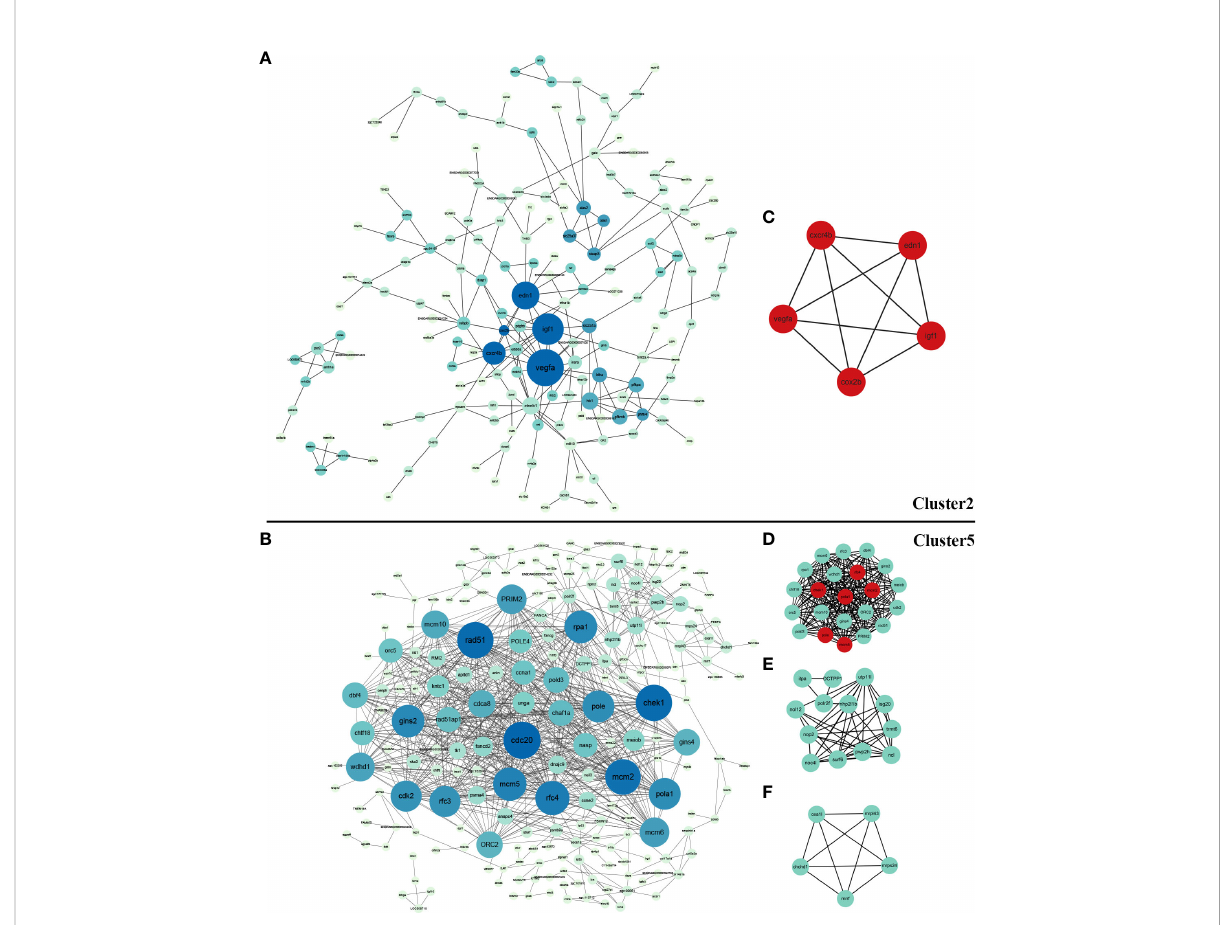
FIGURE 4 Protein-protein interaction (PPI) network and signi fi cant module of DEGs in cluster 2 and cluter 5. (A) PPI network of DEGs in cluster 2 created by STRING and visualized using Cytoscape software; (B) PPI network of DEGs in cluster 5 created by STRING and visualized using Cytoscape software; (C) The signi fi cant module of cluster 2 identi fi ed by MCODE (score = 5.000). The hub genes identi fi ed by Cyto-Hubba analysis were shown in red; (D) The most signi fi cant module of cluster 5 identi fi ed by MCODE (score =20.286); (E) The second signi fi cant module of Cluster 5 identi fi ed by MCODE (score =7.167); (F) The third signi fi cant module of Cluster 5 identi fi ed by MCODE (score =5.000). The hub genes identi fi ed by Cyto-Hubba analysis are shown in